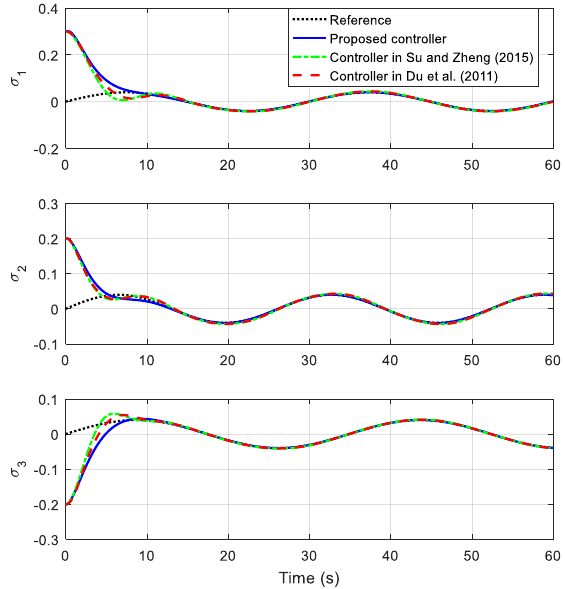
Figure 2. Profile of the attitude tracking σ [18,21].